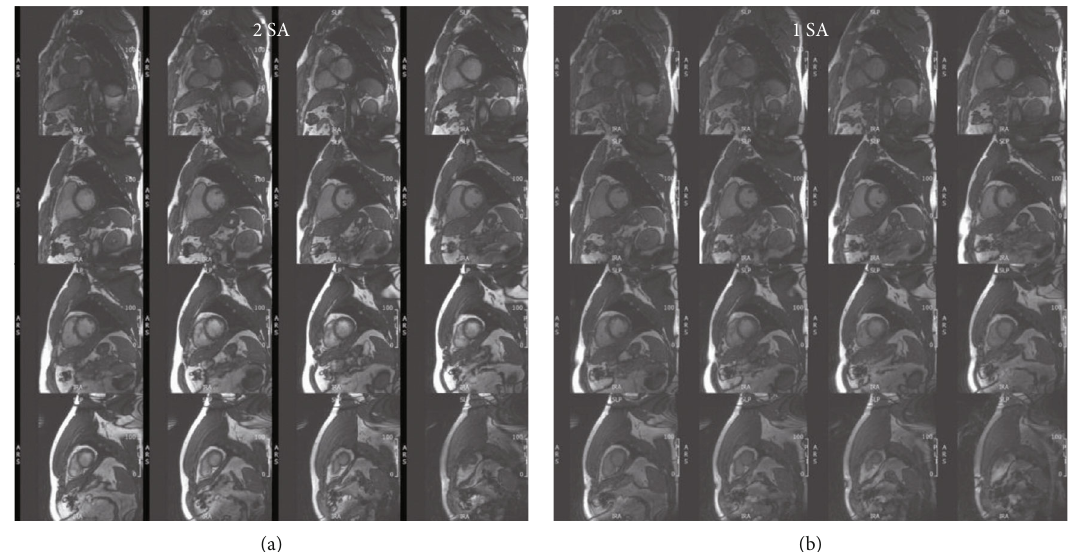
Figure 2: 3D cine acquisition in the short-axis direction. Stacks of short-axis slices covering the heart from base (top left) to apex (bottom right), obtained in the same subject as in Figure 1 using accelerated 3D-cine acquisition with 2 overlapping short-axis (SA) slabs (a) and one thicker SA slab (b). Scan time is 48s and 20s for the 2-slabs and 1-slab acquisitions, respectively.